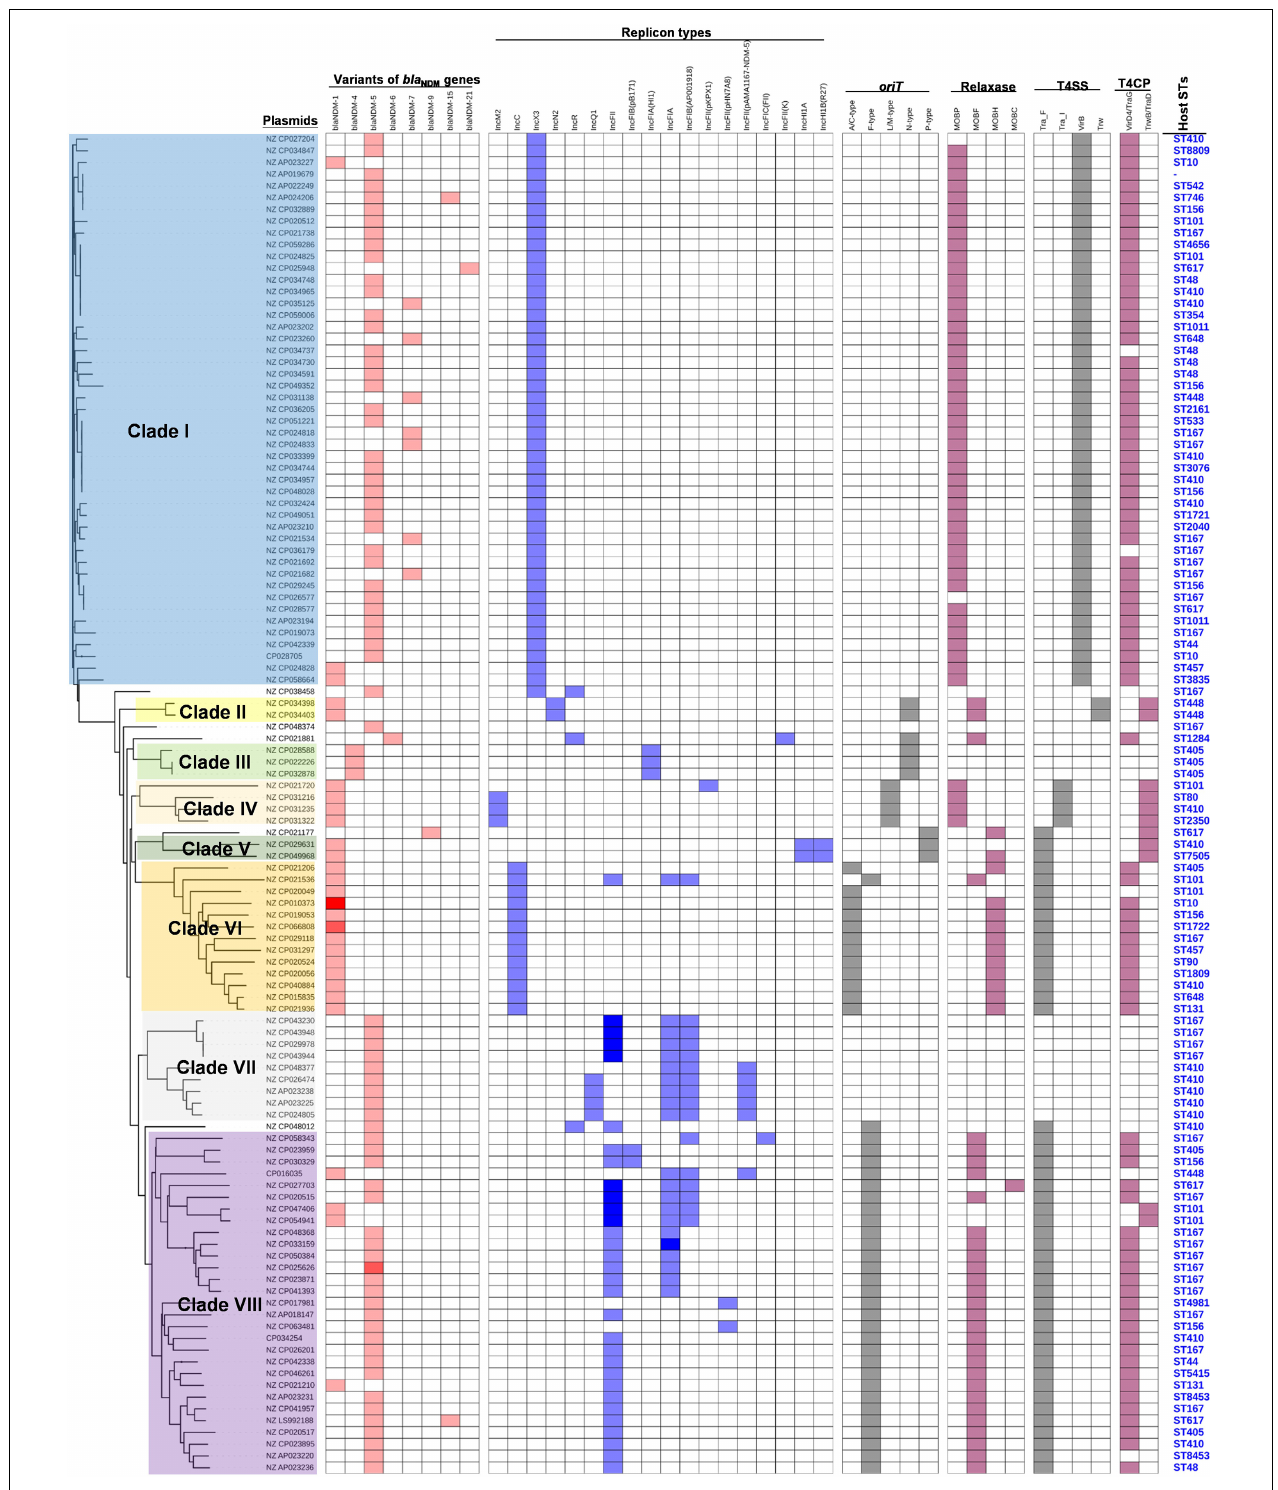
FIGURE 2 | Details of variants of bla NDM genes, replicon types of plasmids, and the conjugative transfer modules of the 114 bla NDM -positive plasmids in E. coli . The five categories of information present in this figure include the phylogenetic tree of 114 bla NDM -positive plasmids, variants of bla NDM genes, replicon types, conjugative transfer modules, and STs of host strains. The gradient of color of each heatmap (variants of bla NDM genes, replicon types, phylogenetic patterns, conjugative transfer modules including oriT , relaxase, T4CP, and T4SS) represents the variable numbers of genes or gene clusters.